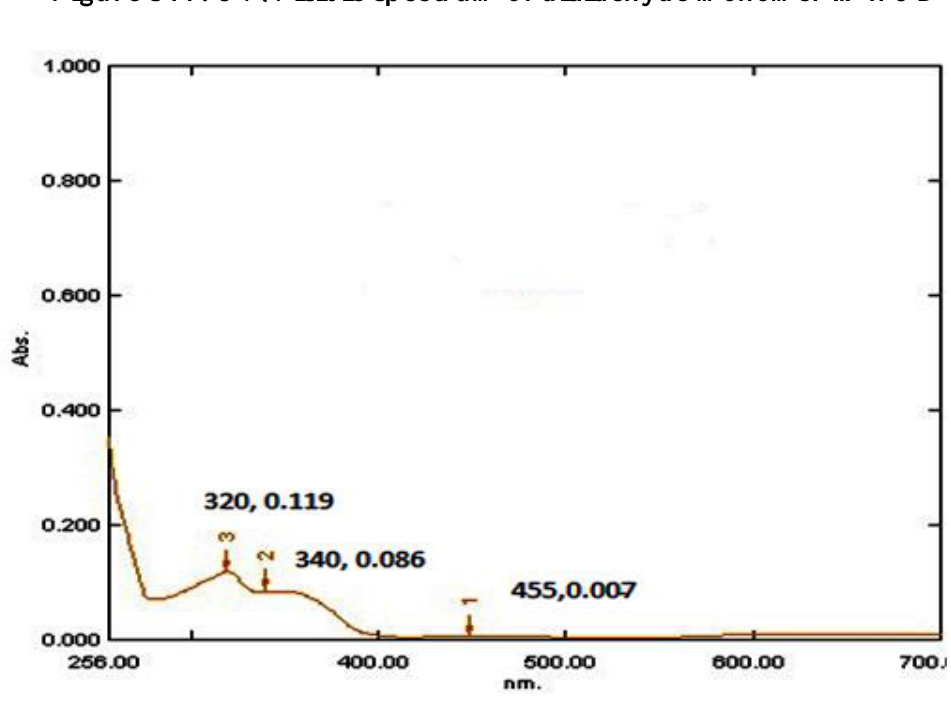
Figure S11: UV/Visible spectrum of dialdehyde monomer m -HOB